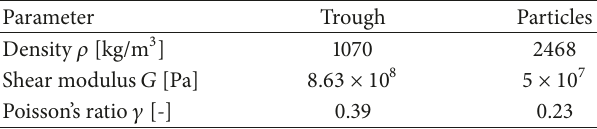
Table 3: Orthogonal test scheme and